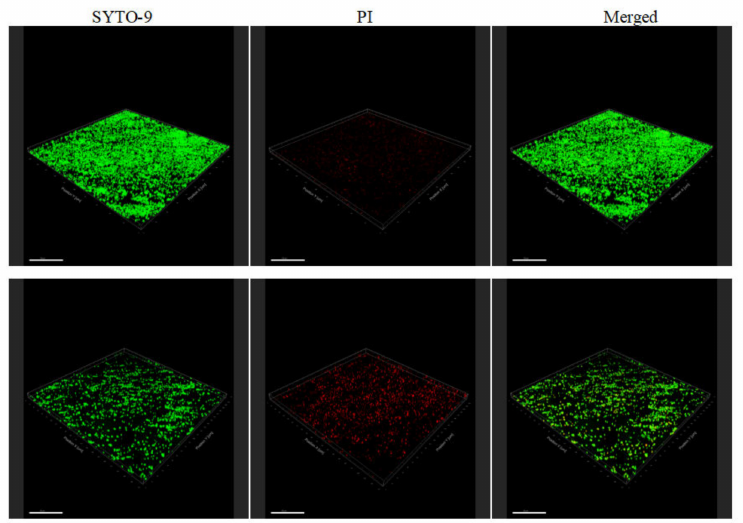
Figure 6. Confocal laser observation of biofilms of S. aureus treated without ( Up ) and with ( Down ) 3/4 MIC plantaricin YKX.